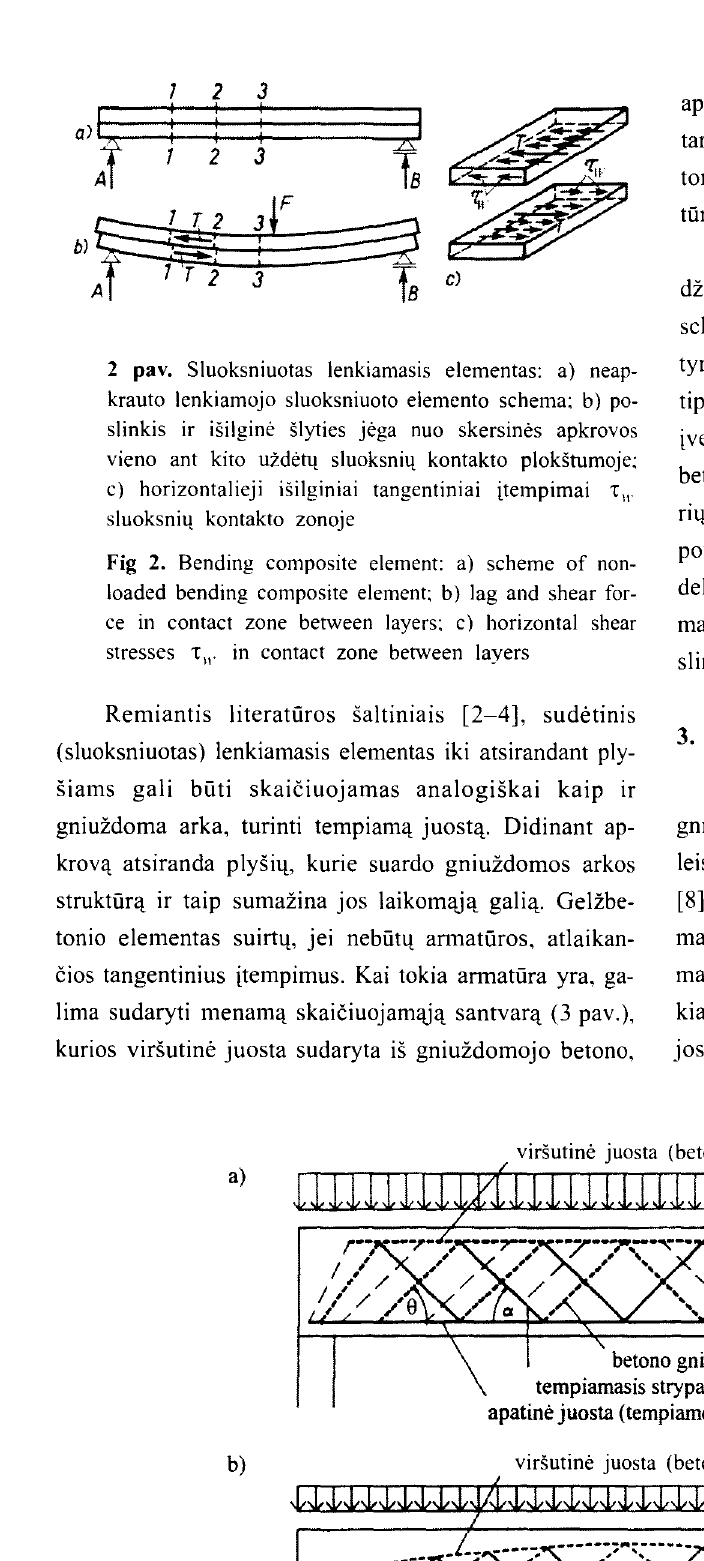
Fig 3. Schemes of imaginary design trusses: a) classical model: b) refined